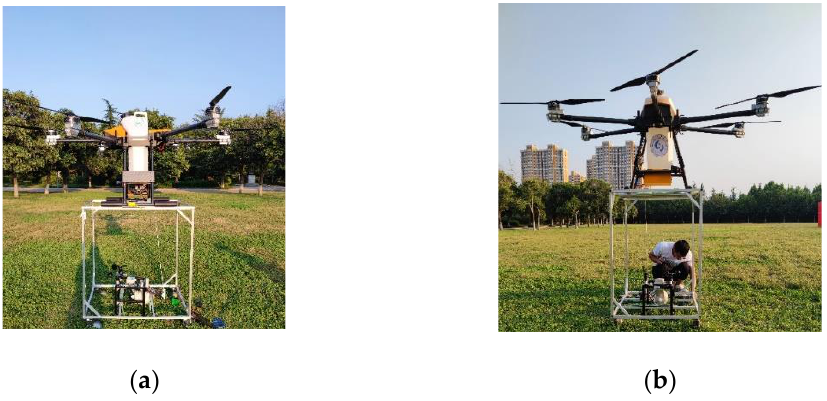
Figure 7. ( a ) Angle 1 and ( b ) angle 2 test on site. ( a ) Angle 1 test on site; ( b ) angle 2 test on site.